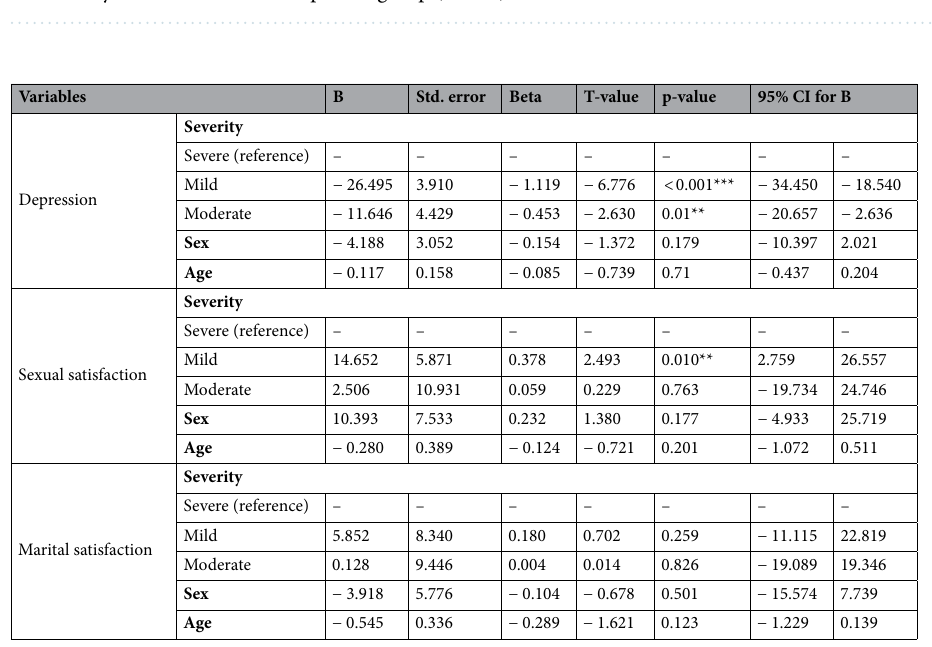
Figure 3. Box plot of differences between sexual satisfaction, depression, and marital satisfaction, in relation to the severity of trauma with in the patient group (n = 55).